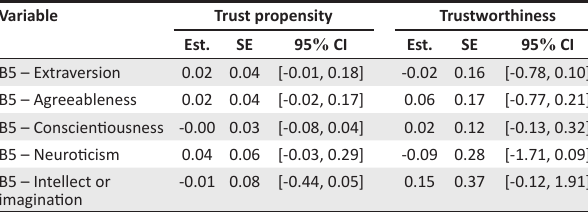
TABLE 4: Indirect effects of the Big Five personality traits.